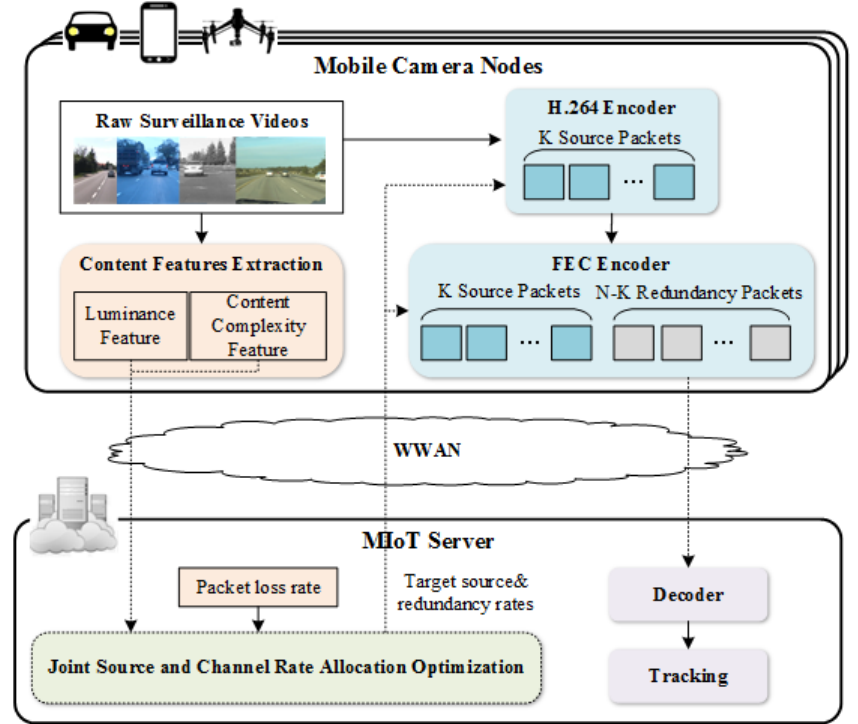
Figure 2. Structure of MIoT system for vehicle tracking.